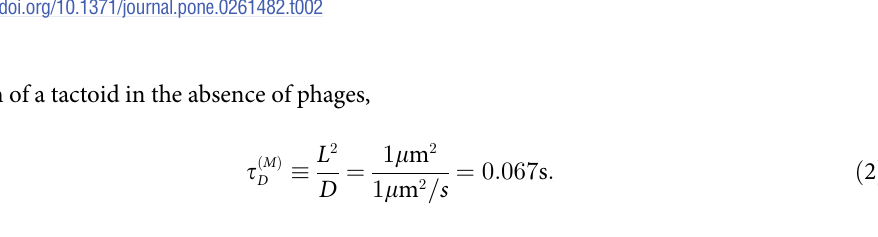
Values are obtained from numerical simulation of the system of equations Eq (1) ( t 90 ) and from the homogenised model ( t H ). D